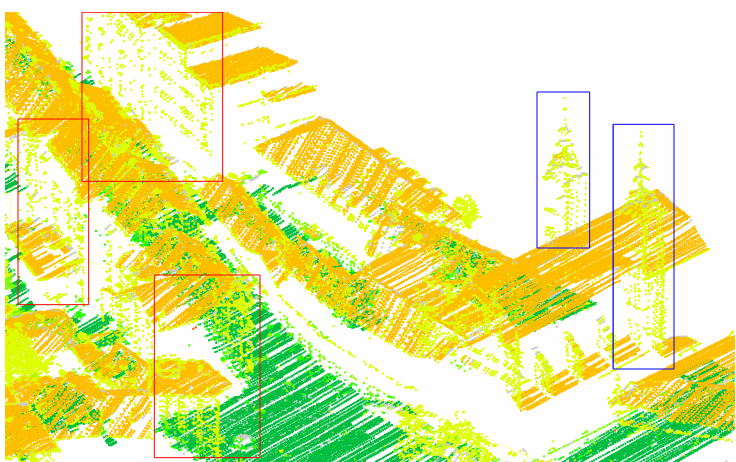
Figure 17. Common misclassification present in the original LiDAR data in Ljubljana city centre where church bell towers are misclassified as trees (blue boxes) instead of building roofs and same is true for points on facades of some buildings (red boxes). Colours of points are: bright green—trees, dark green—ground, and orange—building roofs.